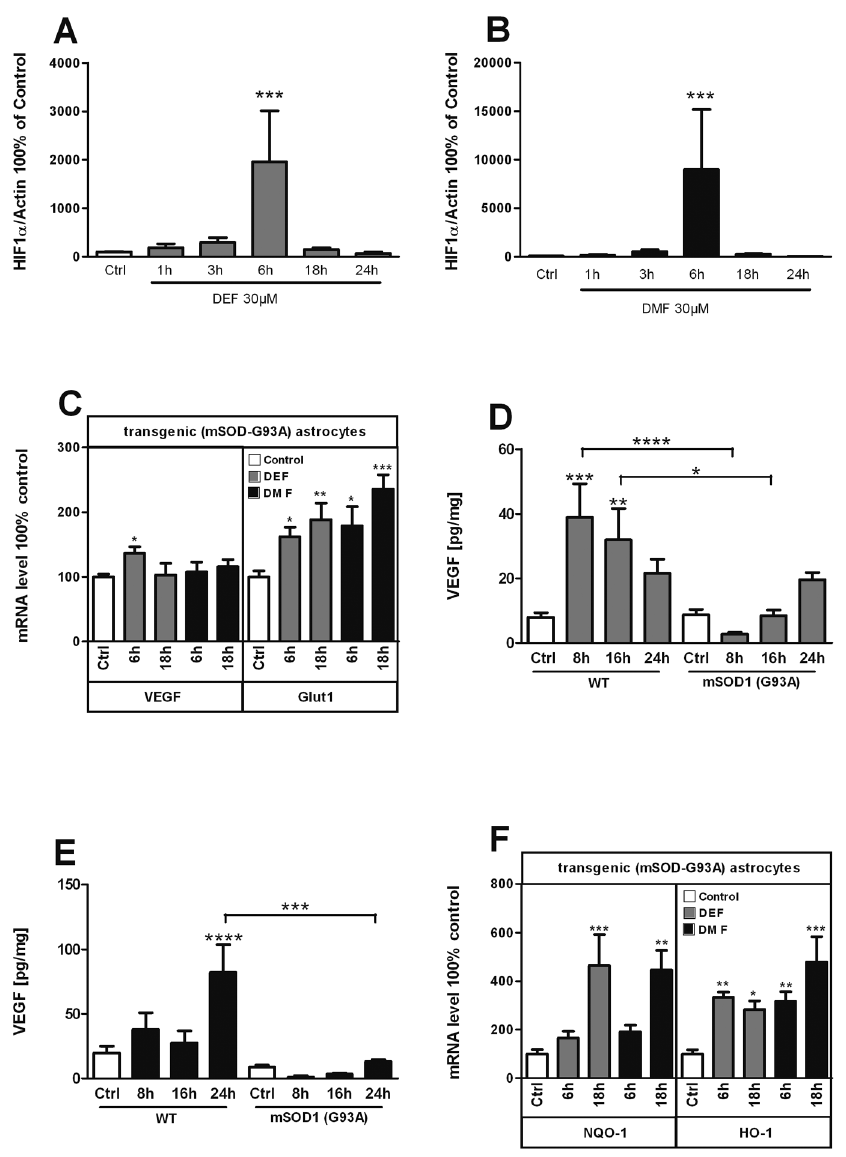
Figure 5. Transgenic (mSOD-G93A) astrocytes show abnormal response to FAEs. Transgenic (mSOD-G93A) astrocytes were treated with 30µM DEF (A,C,D,F) or 30µM DMF (B,C,E,F) for indicated times and the following read-outs were measured; HIF-1α level by Western-Blot (A,B); HIF-1α (VEGF, GLUT1) target genes using qPCR (C). VEGF release as determined by ELISA (D,E); and Nrf2 target genes (NQO-1, HO-1) (F) *p<0,05; **p<0,01; ***p<0,001; significantly different from corresponding control. Values are mean +/- SEM of n=3 independent